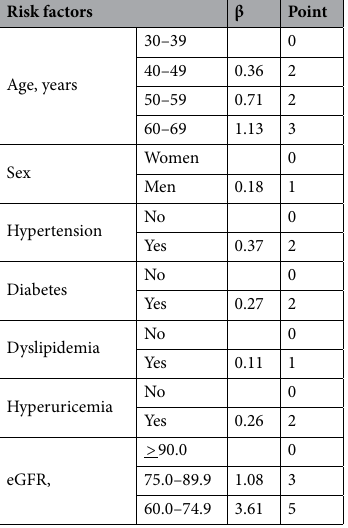
regression,: 1, β = 0.01–0.20; 2, β = 0.21–0.80; 3, β = 0.81–1.20; 4, β = 1.21–2.20; and 5, β > 2.20. The reference category for each variable was given a score of 0. β, standardized regression coefficient.